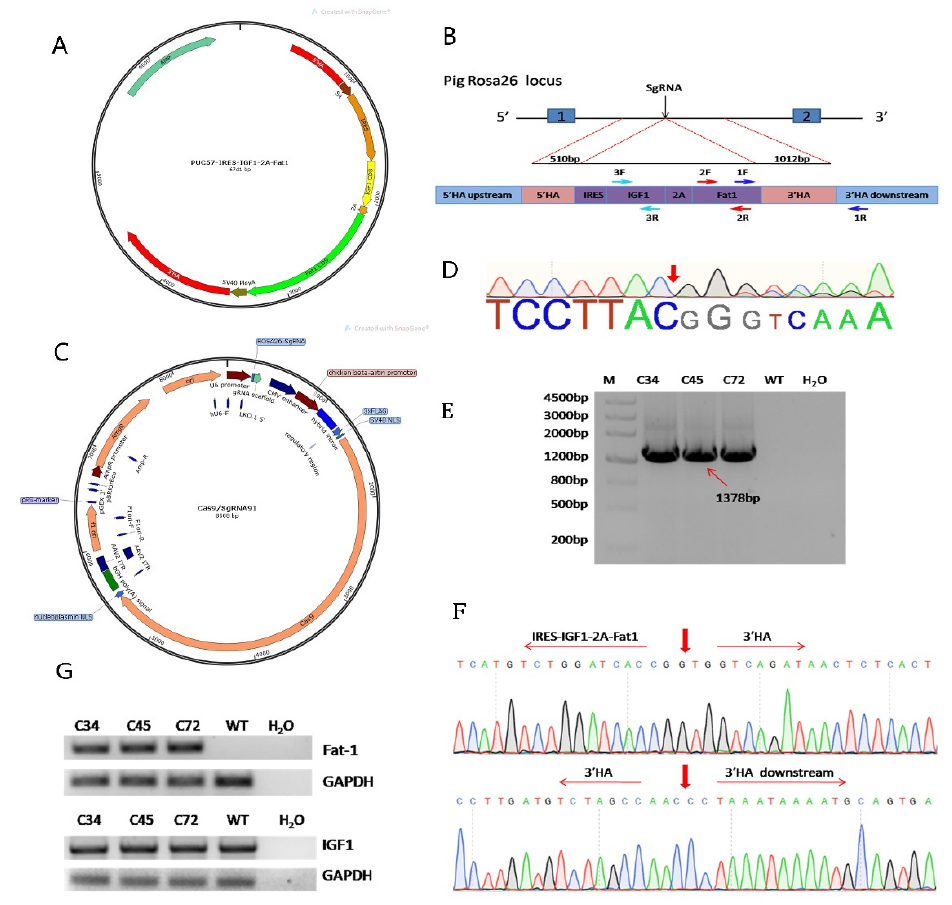
Figure 1. IGF-1 and Fat-1 were integrated into p Rosa26 locus by homologous recombination. ( A ) Schematic diagram of IRES- IGF1 -2A- Fat1 inserted into the donor plasmid. ( B ) Strategy for the Cas9-mediated knock-in of IGF-1 and Fat-1 at p Rosa26 site. ( C ) Schematic diagram of the Cas9/sgRNA plasmid. ( D ) The cleavage site of sgRNA at p Rosa26 locus. ( E ) Screening of PFF clones by PCR with primer 1F/R. The primers 1F and 1R are designed in the upstream of 3’HA and downstream of 3’HA, respectively. M: DNA Marker III, WT: negative control. H 2 O: blank control. ( F ) Sanger sequencing of the products in ( E ). ( G ) RT-PCR was performed with primers 2F/R and 3F/R to confirm that the IGF-1 and Fat-1 genes were transcribed in the positive